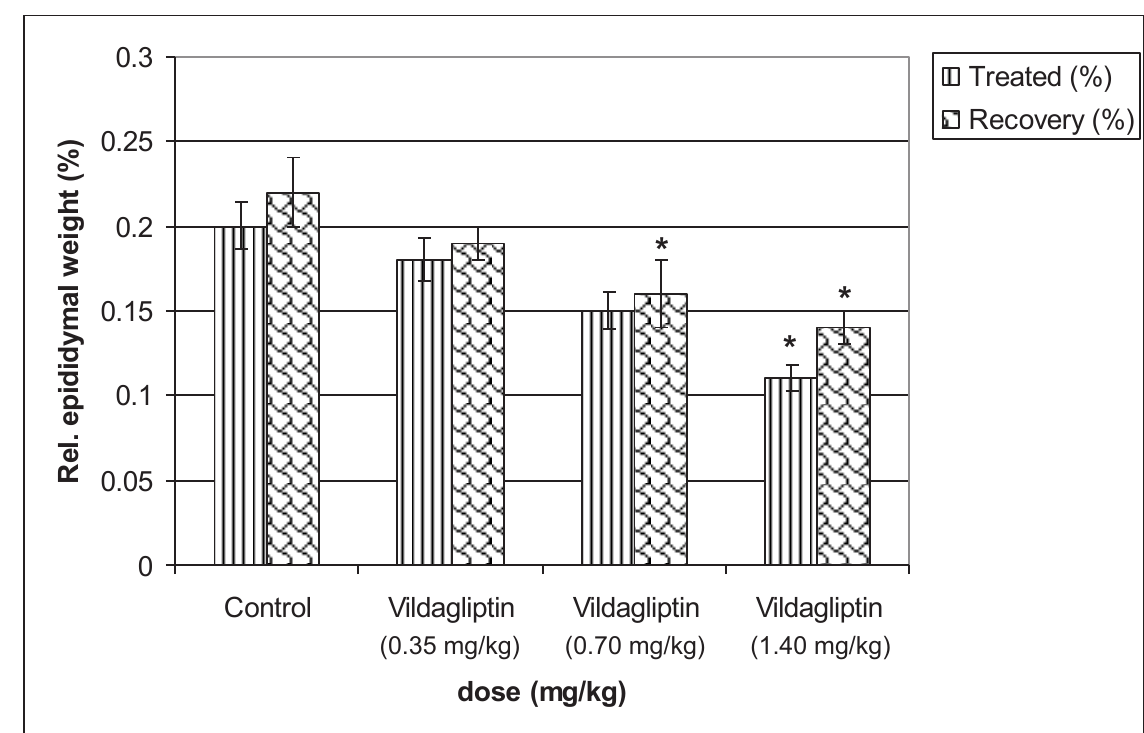
FIGURE 3 – Effects of vildagliptin on relative epididymal weights of male Wistar rats. Graph showing the effects of vildagliptin on the relative epididymal weights of male Wistar rats. * = significantly different from control (p <